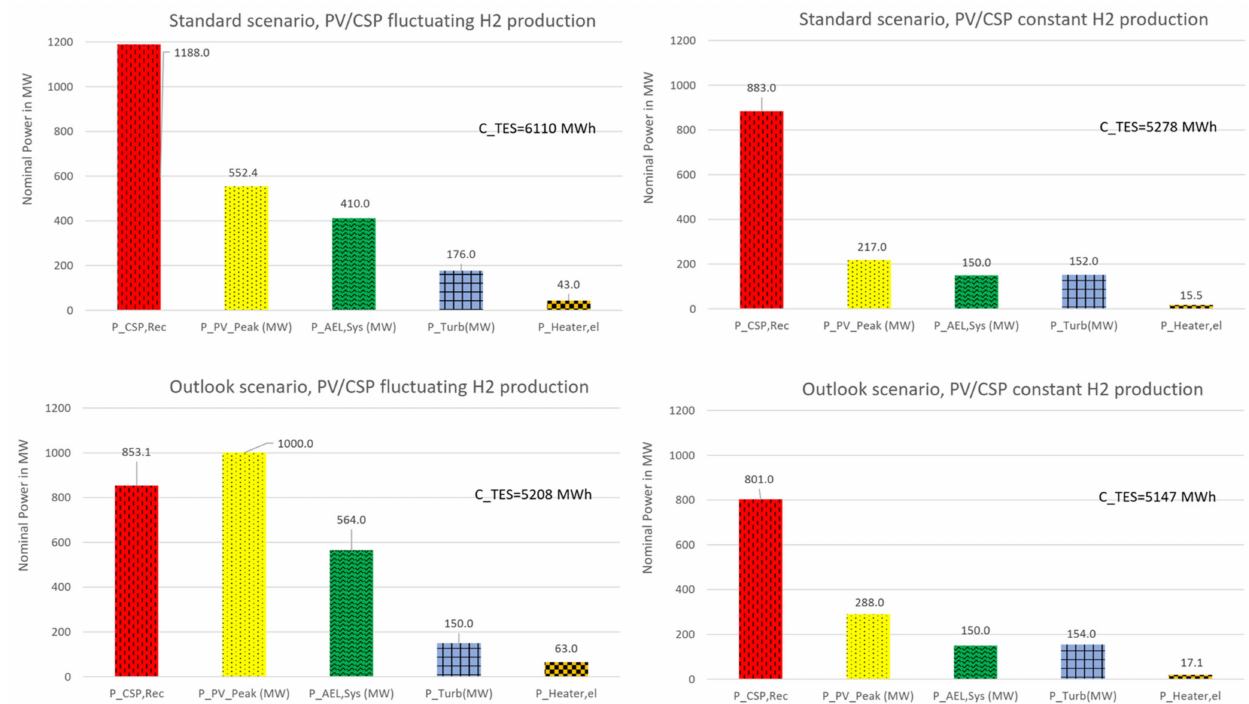
Figure 10. Optimized plant design of PV/CSP-hybrid alkaline electrolyser plants (fluctuating or constant hydrogen production) for the two cost scenarios and the location Ouarzazate, Morocco. Nominal power of process equipment is